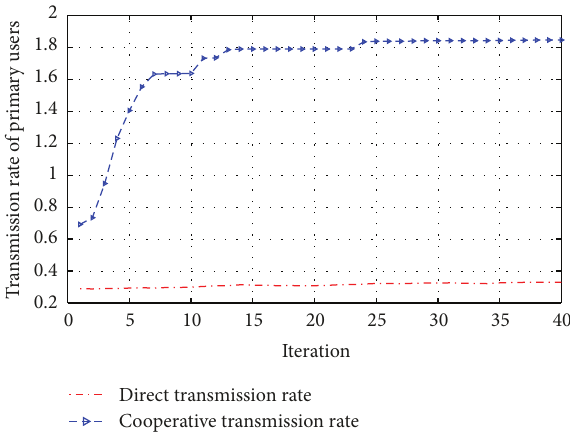
Figure 7: Transmission rate of primary